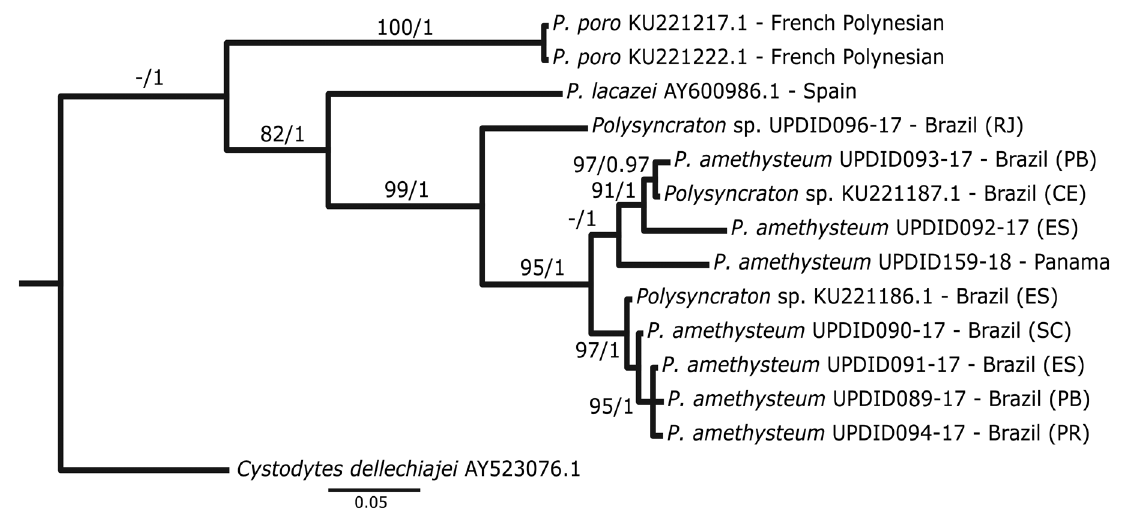
Fig. 5. Maximum likelihood tree of species of Polysyncraton based on analysis of 16 sequences of mitochondrial COI. Numbers on or below branches represent the support value of the bootstrap for Maximum likelihood (> 70%) and posterior Bayesian probabilities (> 0.97). Abbreviations of